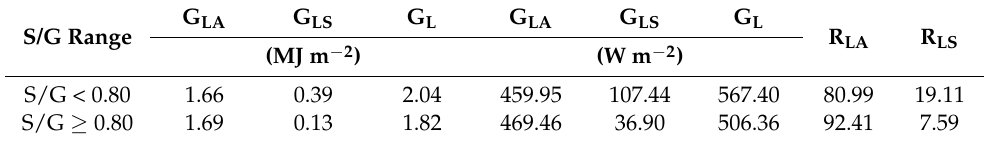
Table 4. Annual mean values of losses of global solar irradiance (MJ m − 2 ) and radiation (W m − 2 ) caused by absorbing and scattering substances (G LA and G LS ), total loss (G L = G LA + G LS ), and their contributions to total loss (R LA and R LS , %) for situations with S/G < 0.80 or S/G ≥ 0.80, respectively. Annual mean values were calculated using the extinction factor (AF) method, as explained in the text.